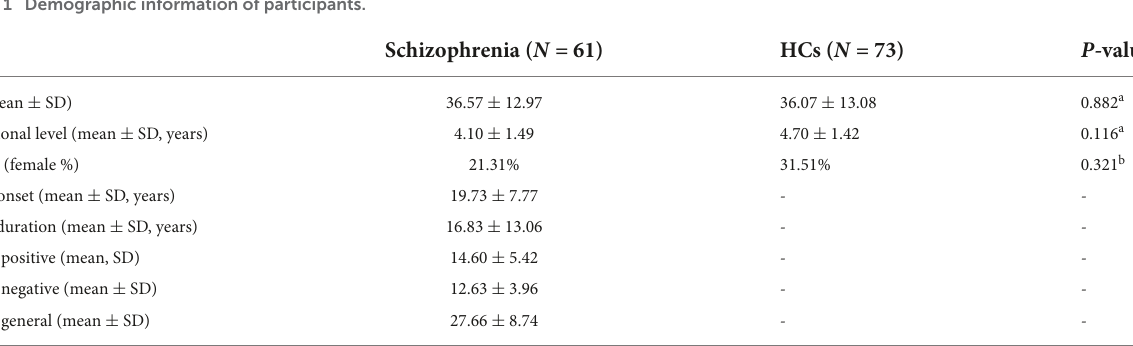
TABLE 1 Demographic information of